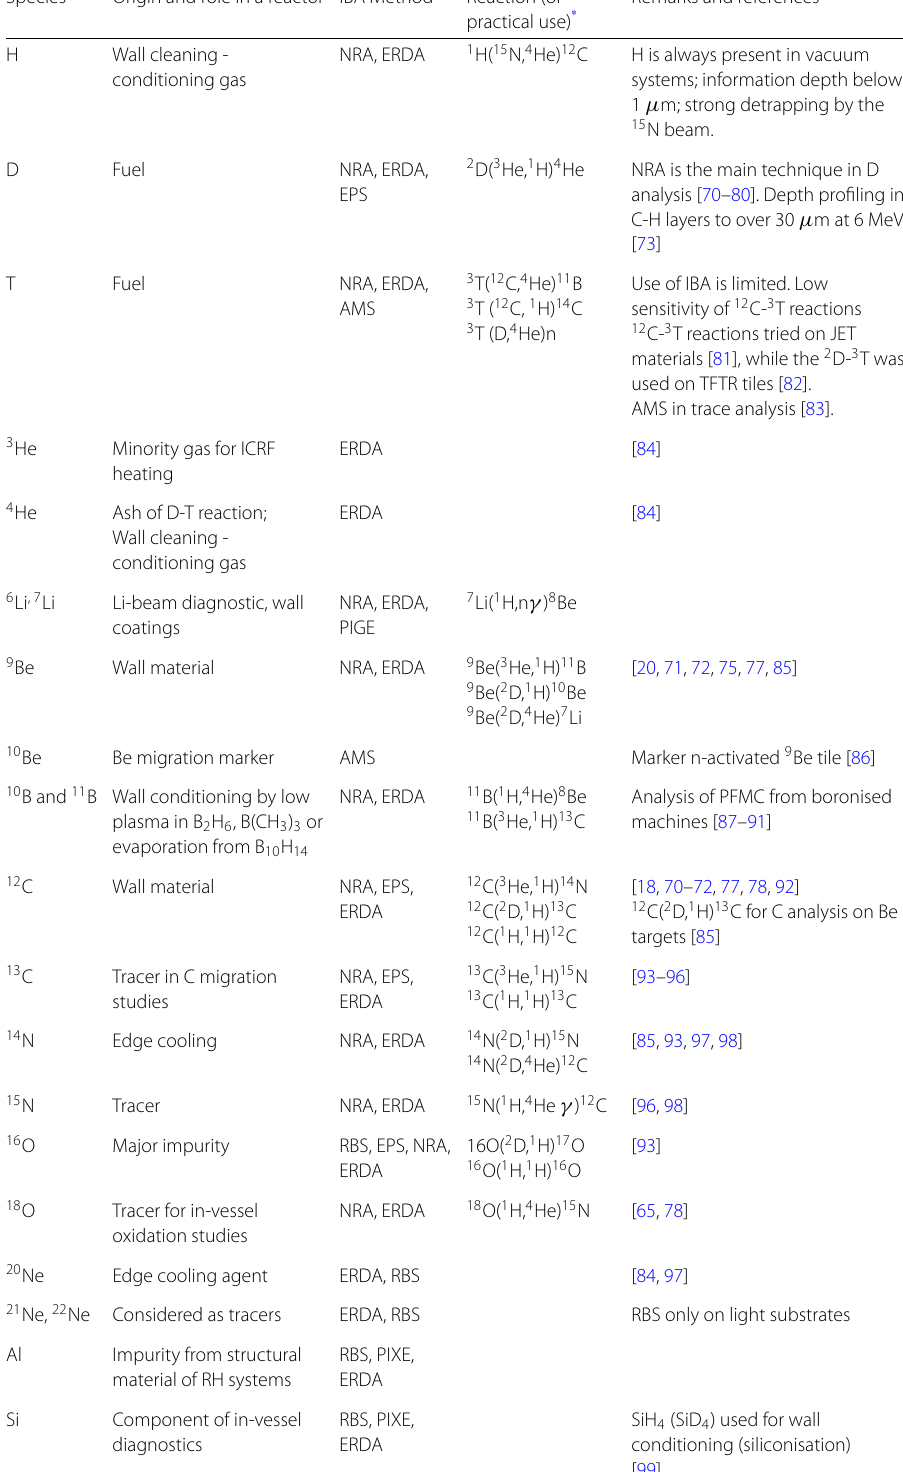
Table 2 Species to be analysed/determined and their role in a reactor Species Origin and role in a reactor IBA Method Reaction (of